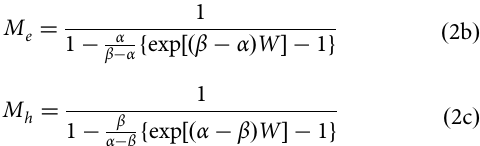
Fig. 2e, f show these ionization coef fi cients for a range of GaAsBi containing samples over a wide range of electric fi elds.